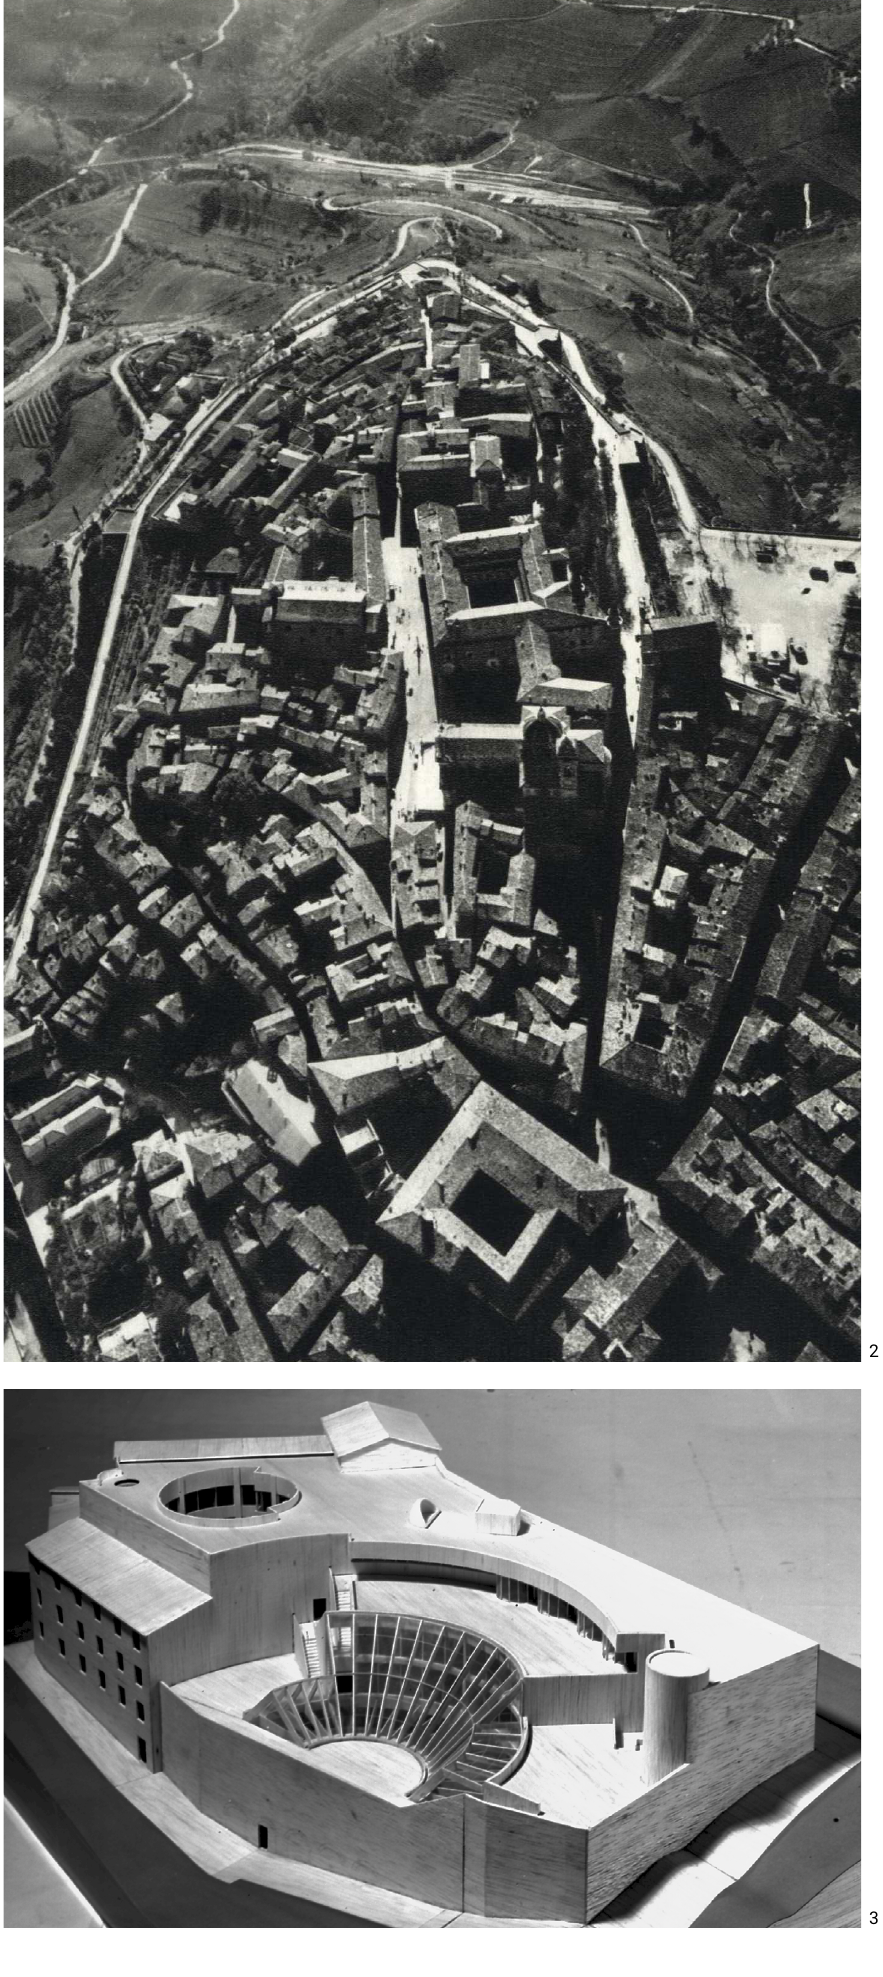
Fig. 2 Urbino, aerial view, from Urbino. La storia di una città e il piano della sua evoluzione urbanistica ,1966 Fig. 3 Urbino, Magistero Faculty, model, credits Università